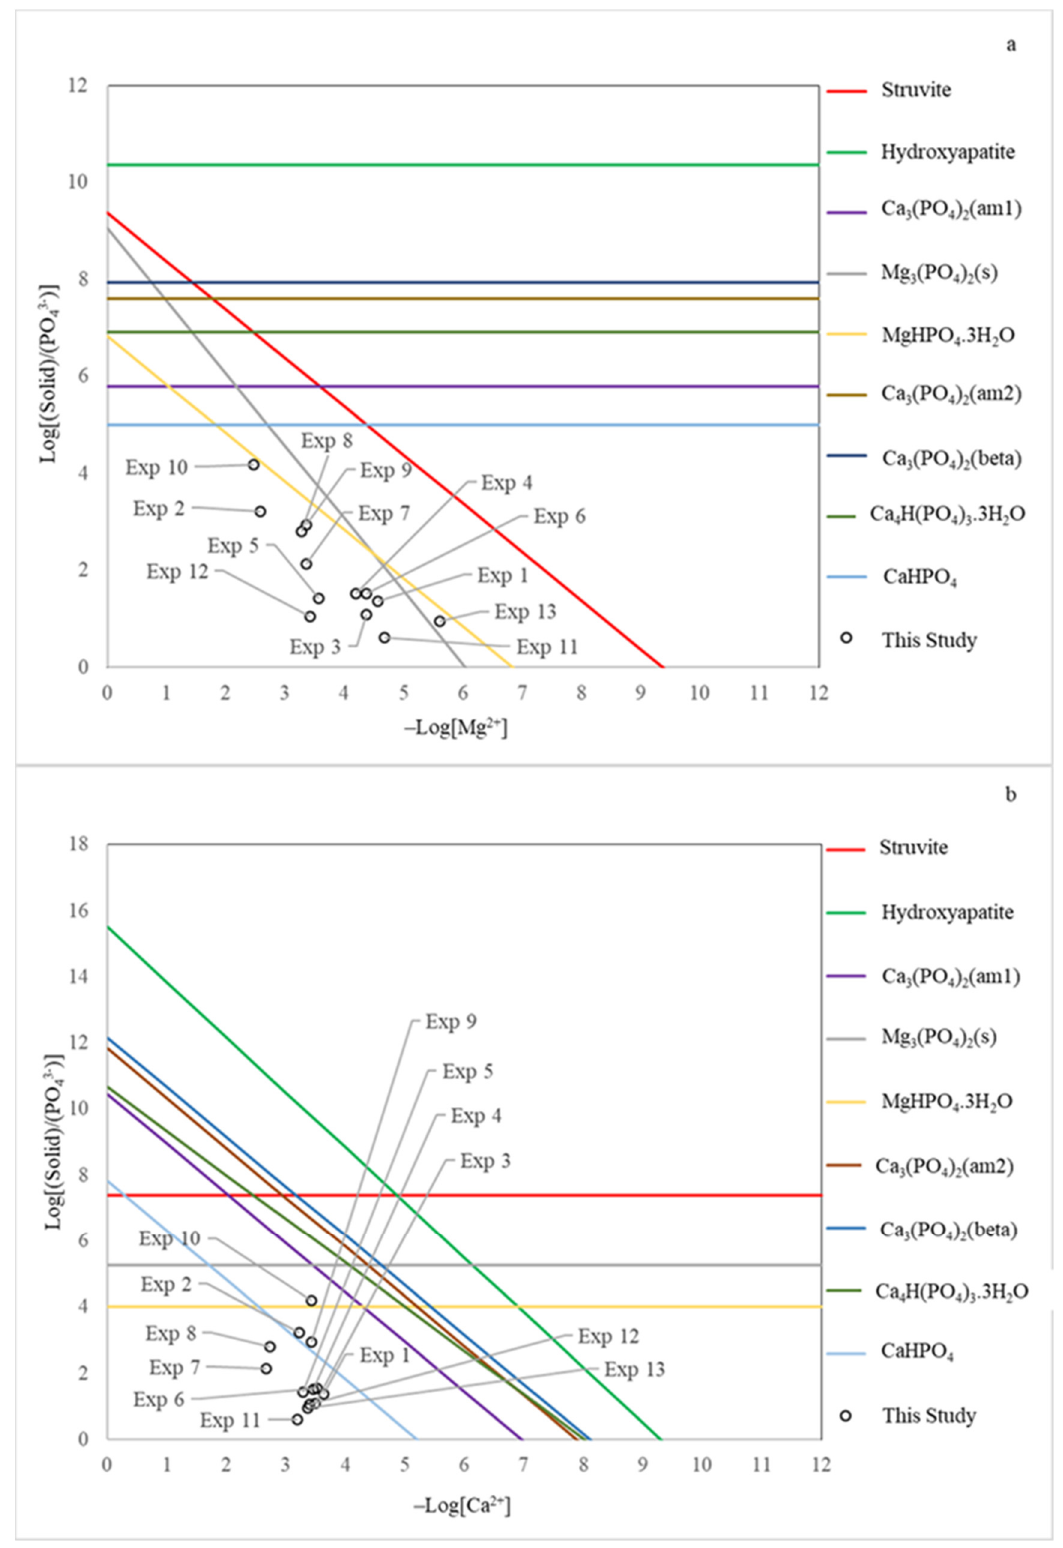
Figure 5. Activity ratio diagrams for: ( a ) PO 43 − solid phases vs. Mg 2+ . pH = 9.5, NH 4+ = 0.0527 M, Ca 2+ = 0.001 M; ( b ) PO 43 − solid phases vs. Ca 2+ . pH = 9.5, NH 4+ = 0.0527 M, Mg 2+ = 0.0026 M.